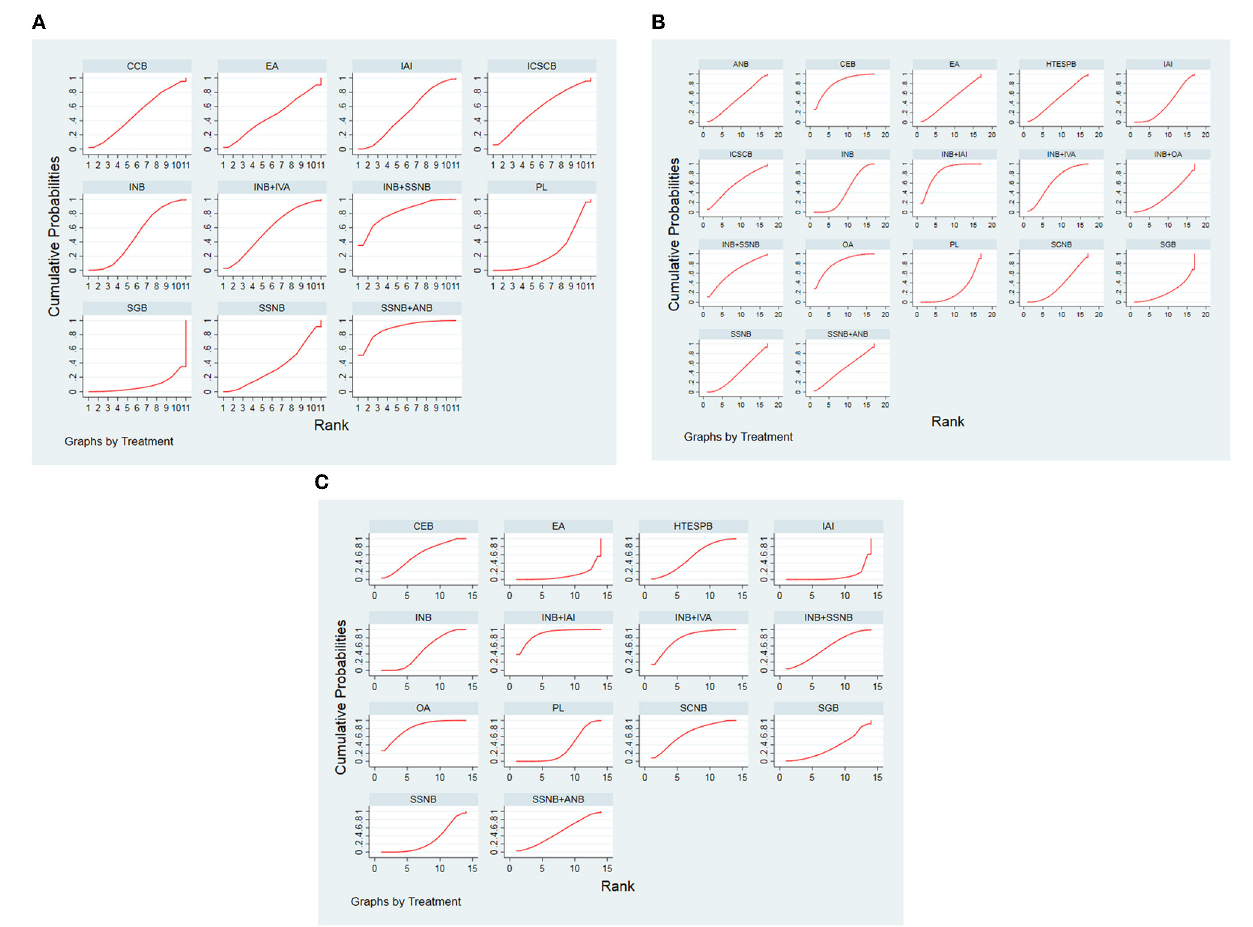
FIGURE 5 | (A) SUCRA for results of postoperative 12h. (B) SUCRA for results of postoperative 24h. (C) SUCRA for results of postoperative 48h. The area under the curve represents the cumulative rank probability of each treatment; with larger areas signifying higher probabilities. INB, interscalene nerve block; SCNB, supraclavicular nerve block; SSNB, suprascapular nerve block; HTESPB, high thoracic erector spinae plane block; CEB, cervical epidural block; SGB, stellate ganglion block; ICSCB, infraclavicular-suprascapular blocks; CCB, costoclavicular blocks; ANB, axillary nerve block; IAI, intra-articular injection; OA, oral administration; EA, external application; IVA, intravenous administration; PL,